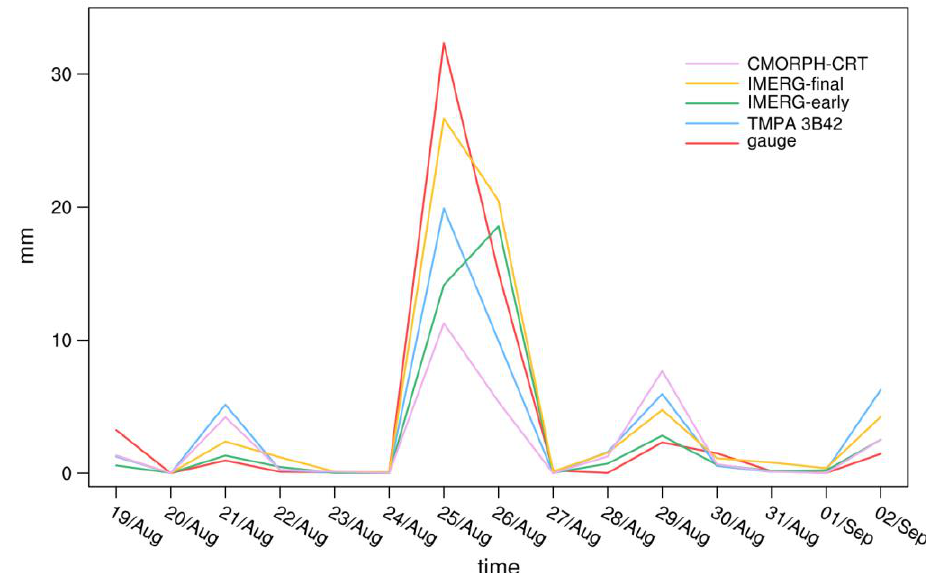
Figure 9. Daily time-series between 19 August 2019 and 2 September 2019 of the mean precipitation in the rainfall center.